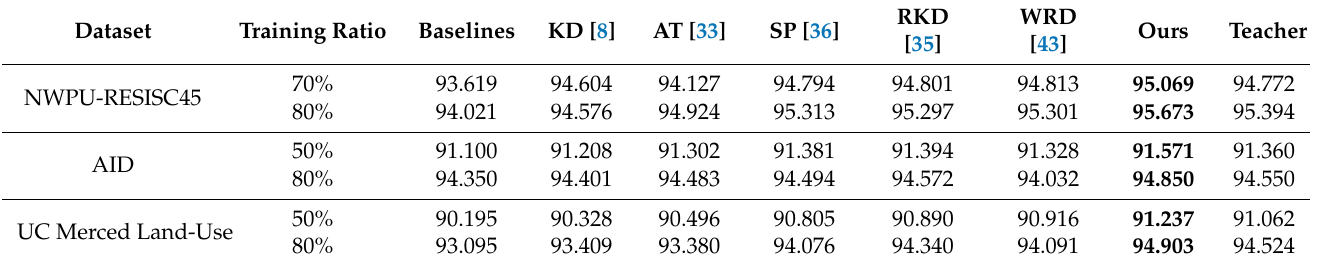
Table 2. Overall accuracy (%) on NWPU-RESISC45 dataset. The ResNet-101 is adopted as the teacher network and ResNet-34 is employed as the student network. The baseline represents the standard back-propagation for the